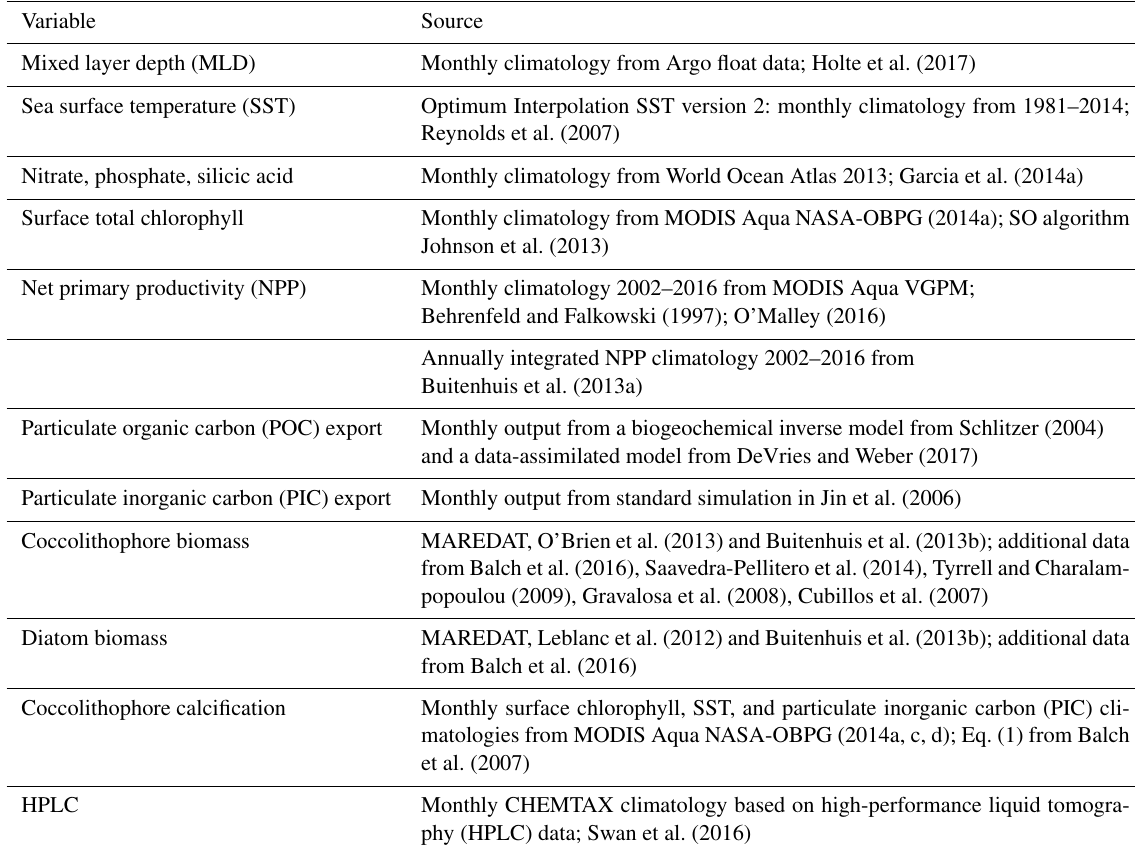
Table A1. Data sets used for model evaluation. Please see Sect. S1 for a more detailed description of the data used to evaluate simulated phytoplankton biogeography, community structure, and